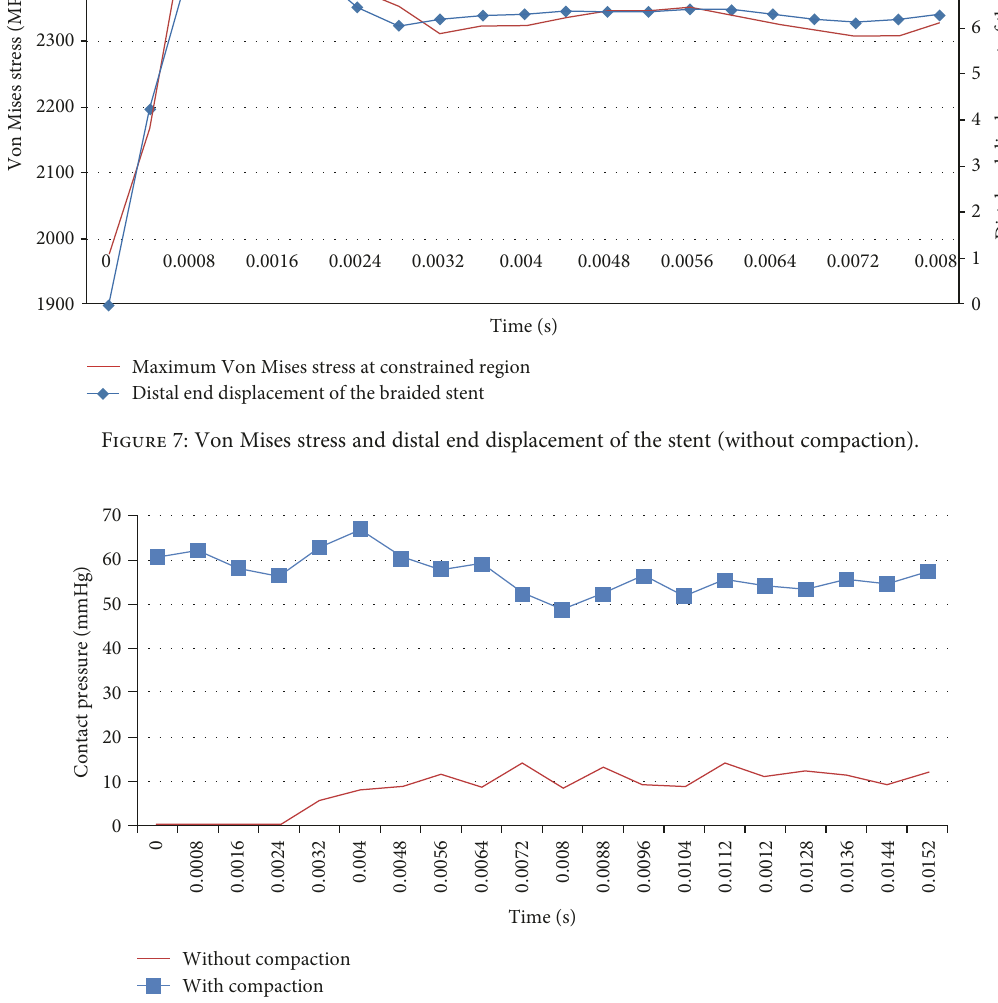
Figure 8: Mean contact pressure of the vascular wall in the aneurismal ori fi